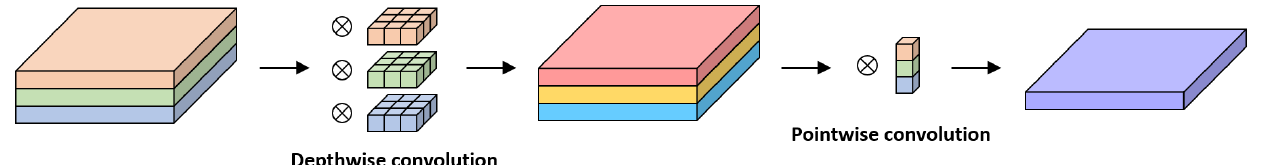
Figure 3. Depthwise separable convolution